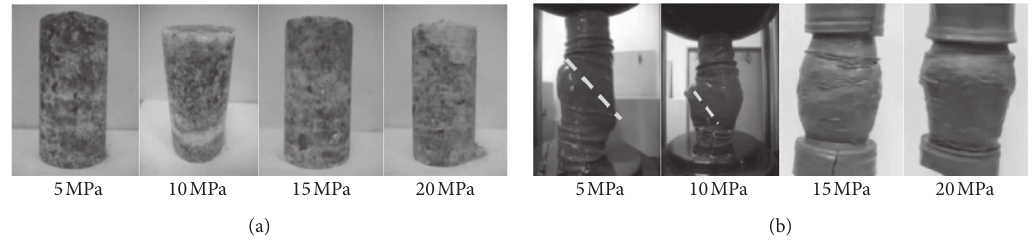
Figure 2: Comparison of salt rock (a) before the creep test and (b) after the creep test